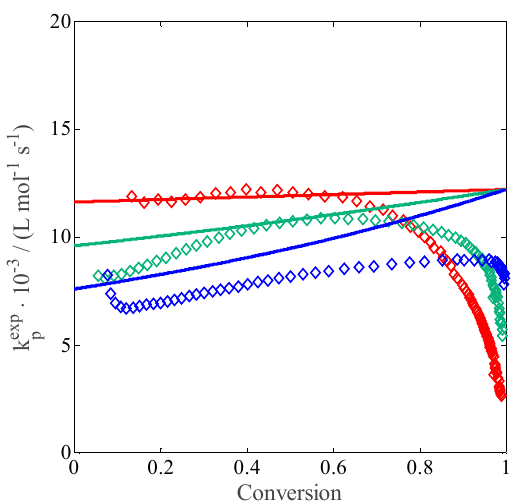
Figure 3. Propagation rate coefficient as a function of the monomer conversion calculated from the termination rate coefficient reported in Table 3 and the experimental data of conversion versus time of non-ionized MAA polymerization (diamonds) at an initial monomer concentration equal to 1 wt % (red), 5 wt % (green), and 10 wt % (blue): comparison with the simulated k p using the model equations (lines).